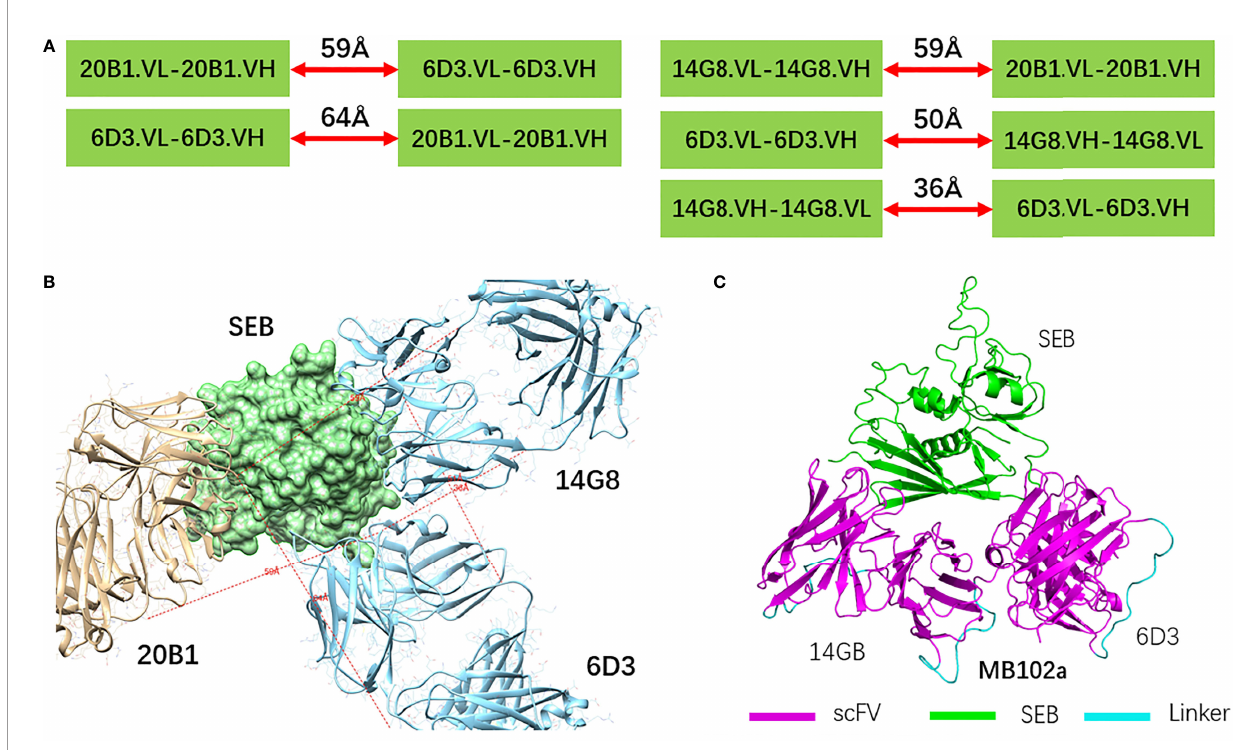
FIGURE 1 | Construction of bispeci fi c scFVs (A) Five possible combinations considered to construct bispeci fi c scFVs from three antibodies 20B1, 6D3 and 14G8. The minimal linker length are indicated using red arrows. (B) By superimposing of SEB-20B1 (PDB 4RGM) and SEB-6D3-14G8 (PDB 4RGN) structures on SEB to probe possible linker connecting nearby scFVs. SEB molecule is represented as green surface (C) Designed bispeci fi c scFV antibody MB102a by connecting variable domains of 14G8FV and 6D3FV.